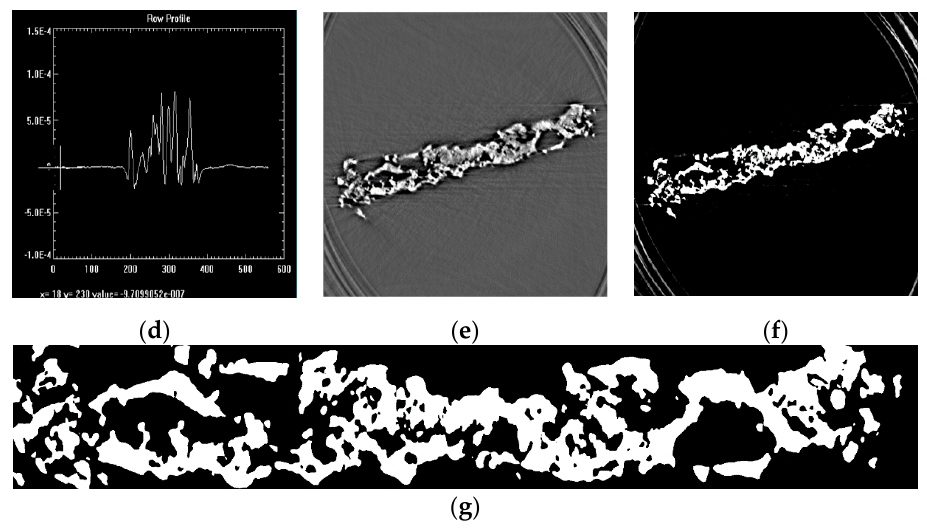
Figure 3. ( a ) The shadow images by X-ray tomography (i.e., PPCT projections); ( b ) images after flat-field and dark-field correction; ( c ) the result after phase retrieval; ( d ) row profile of Figure 3d; ( e ) reconstruction image slices obtained after the step of slice reconstruction; ( f ) the output data of 8bit TIFF images; and ( g ) the final full image of 100% scale after 2D image processing.